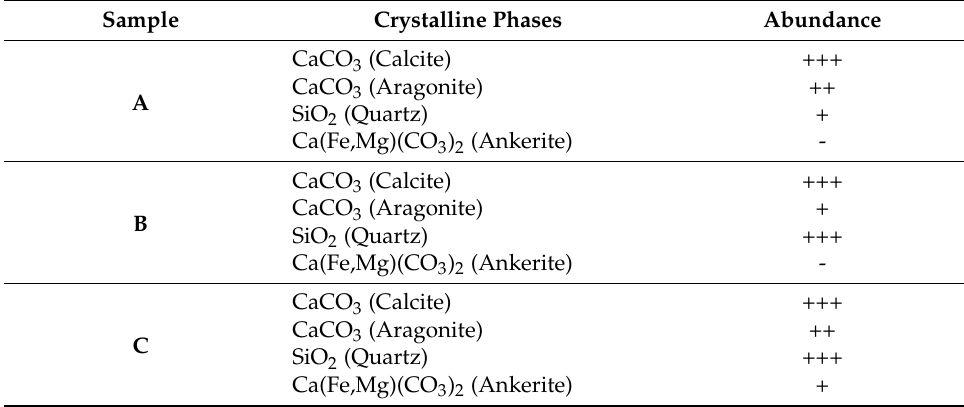
Table 2. Semiquantitative XRD analysis of A, B, and C mortar samples.